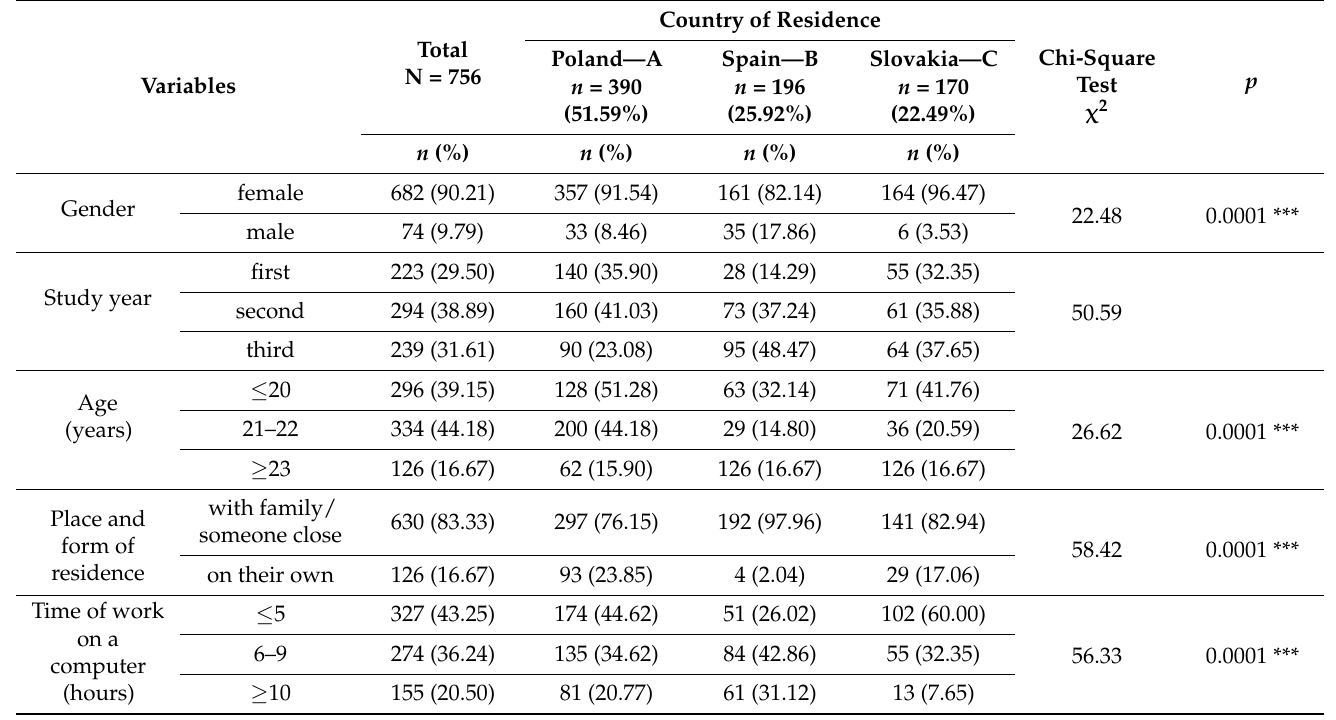
Table 1. Characteristics of the studied